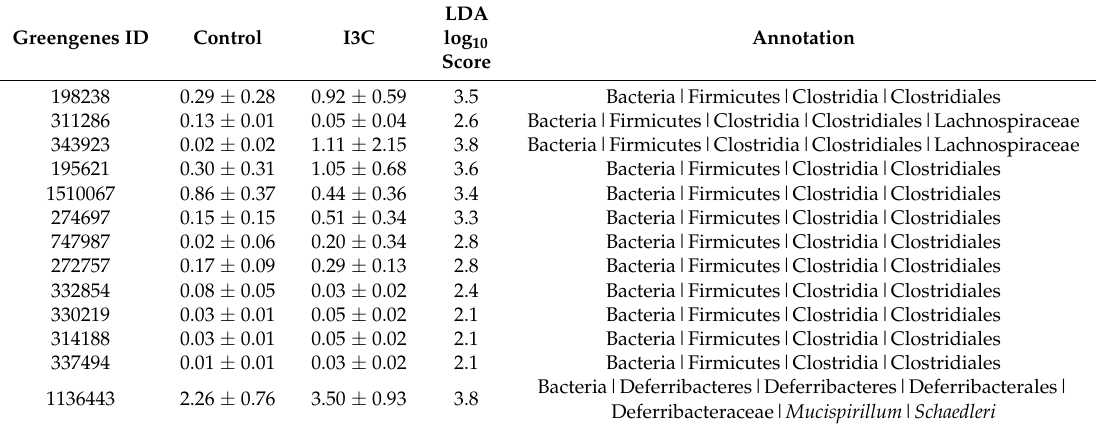
Figure 1. Alteration of cecal microbiota in control and indole-3-carbinol (I3C)-treated mice after LNCaP (ATCC CRL-1740) human prostate cancer cell injection. ( A ) the phylum-level microbial composition (bars represent relative abundance of samples from individual mice); ( B ) a cladogram representation based on operation taxonomic unit (out) table (the circles from inside to outside correspond to taxonomy from phyla to species, yellow and red circles represent non-significant and significant microbial clades, respectively); ( C ) the relative abundance of Mucispirillum schaedleri in control and I3C groups (* means p ≤ 0.05, Mean ± SD, n = 9). Table 2. Fourteen species-level OTUs with significant differences in relative abundance between the mice fed diet with or without I3C ( p < 0.01). The numbers denote mean ± SD (percentage composition). Results are based on a Wilcoxon non-parametric t -test corrected for multiple hypothesis testing (LDA score log 10 > 2.0).